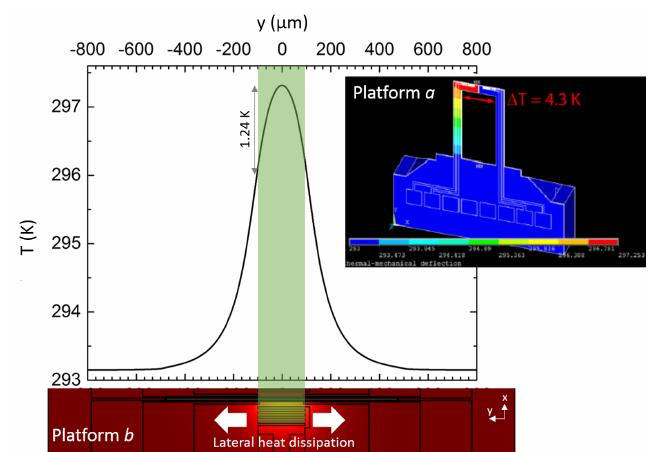
Figure 7. Temperature distribution along the thermometer for the hot side of TNCP b . The inset shows the simulation, made on an older generation of Platform a , with different dimensions, compared to the one that is implied in this work. However, as the basic design is cantilever-based, this comparison is valid. The inset shows data from [25], with permission from Elsevier.